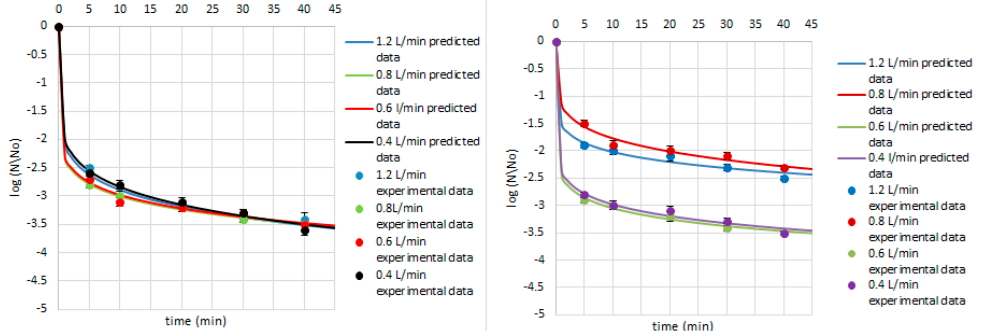
Figure 7. Survival of E. coli on the cardamom seed ( left ) and juniper berry ( right ) matrix treated with ozone doses stimulated with flow rate of 1.2, 0.8, 0.6, and 0.4 L/min after 5, 10, 20, 30, and 40 min. Solid line: fit of the Weibull model (egn 1), dotted line: bacterial log counts.